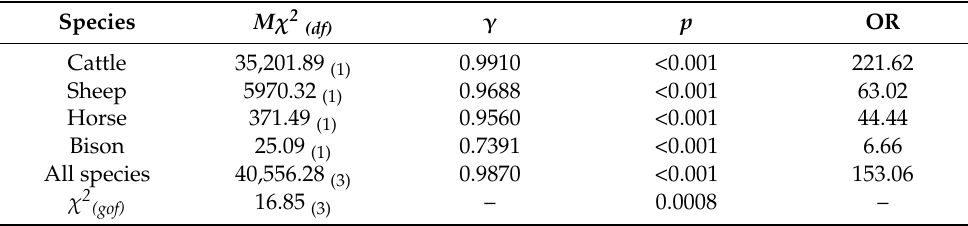
Table 2. Output summary table of McNemar chi-squared ( M χ 2 ) tests and Chi-squared goodness-of-fit ( χ 2 (gof) ) tests comparing observed versus expected death loss of cattle, sheep, horse, bison, and across all species during Blizzard Atlas in early October